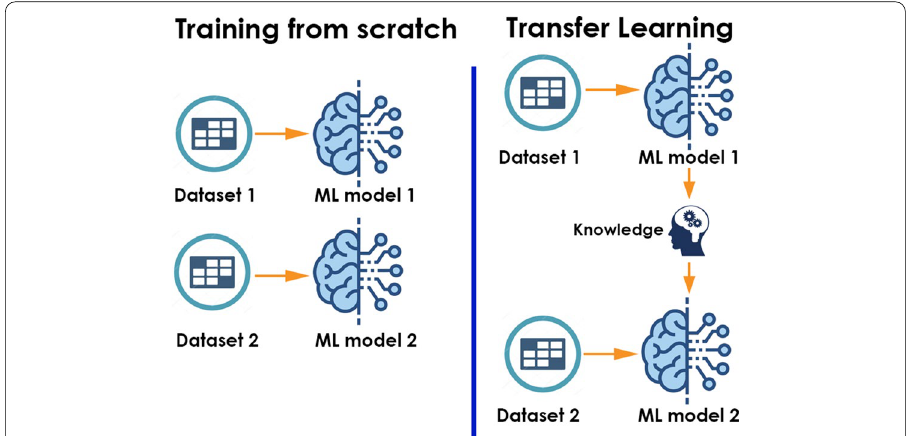
Fig. 4 Difference between training a model from scratch and transfer